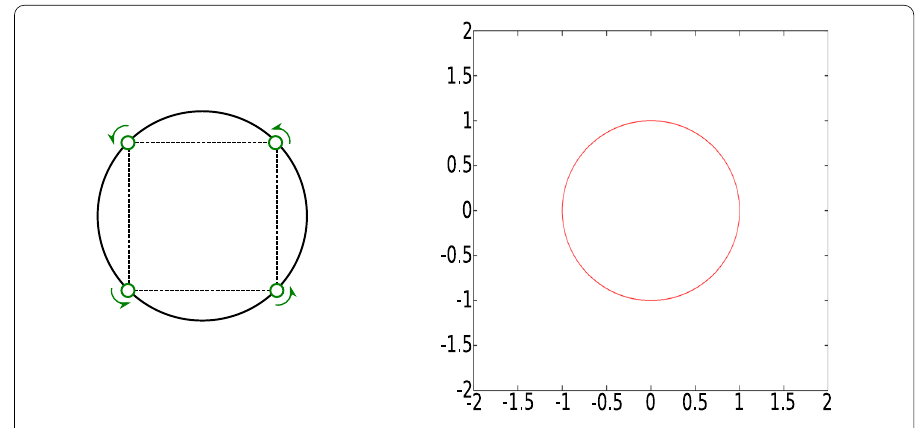
Fig. 7 Initial configuration with square symmetry (left) and trajectory